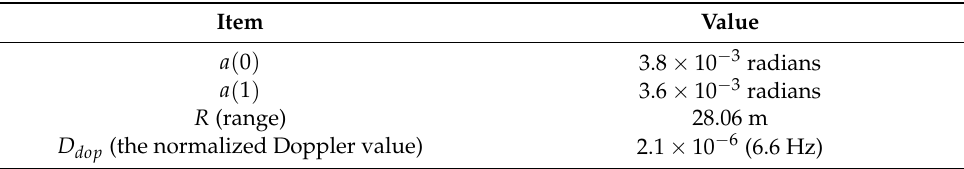
Table 3. Measured RMS tracking